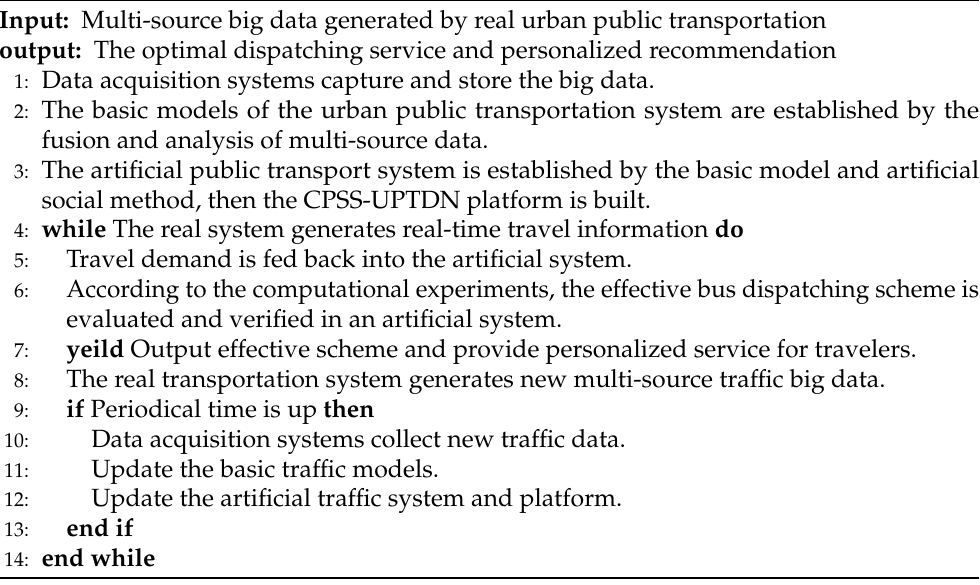
Algorithm 1 The pipeline of